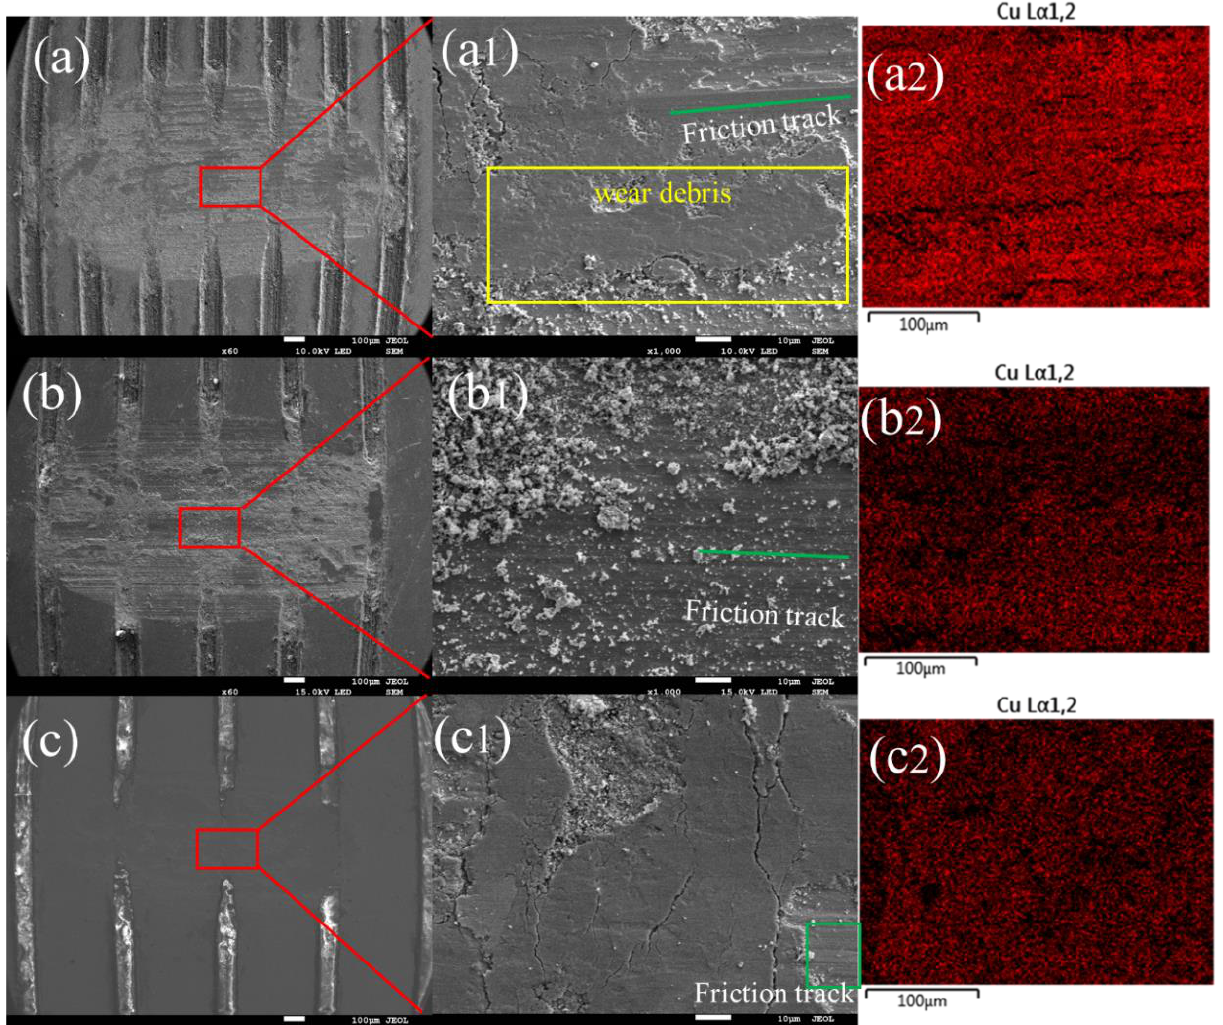
Figure 8. SEM images and Cu elemental mappings of the worn surfaces of Mn-Cu samples (T0.3- W0.1-N2 group). ( a ) The sample with a center distance of 0.3 µ m. ( b ) Shows the sample with a center distance of 0.4 µ m. ( c ) Shows the sample with a center distance of 0.5 µ m. ( a1 ) Partial enlargement of a-graph. ( b1 ) Partial enlargement of a-graph. ( c1 ) Partial enlargement of c-graph. ( a2 , b2 , c2 ) Copper contents different friction